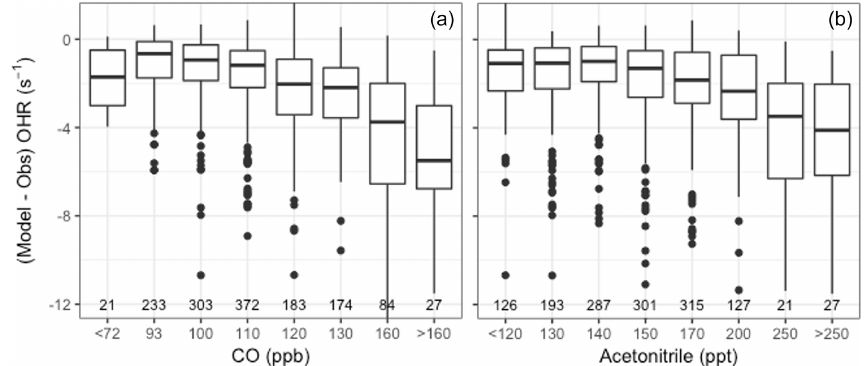
Figure 6. Boxplots of the model minus observed OHR or OHR difference during the DC3 campaign against binned CO (a) and acetoni- trile (b) observations. The number of observations in each bin is shown at the bottom of the